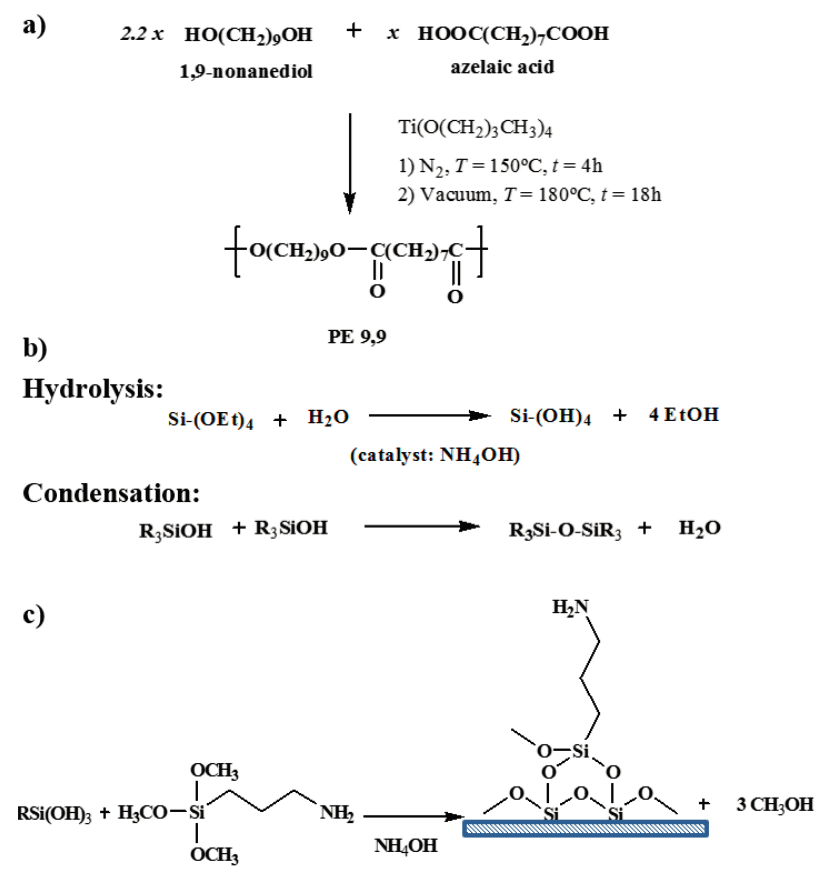
Figure 2. Synthesis schemes for PE99 ( a ); silica spheres ( b ); and functionalization process ( c ). Preparation of silica micro/nanoparticles (Figure 2b): Deionized water (0.6 mL) and 1.2 mL of a 28% aqueous ammonium hydroxide (1.2 mL) (Aldrich, Madrid, Spain) were added to a flask of 100 mL containing absolute ethanol (50 mL). The mixture was stirred vigorously for 20 min at